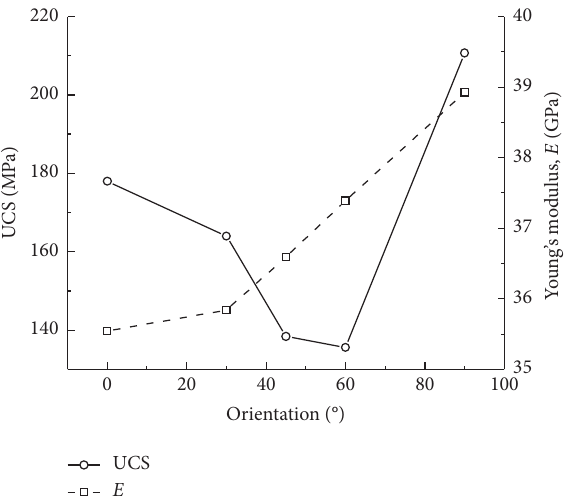
Figure 10: Relationships between the UCS, Young’s modulus, and